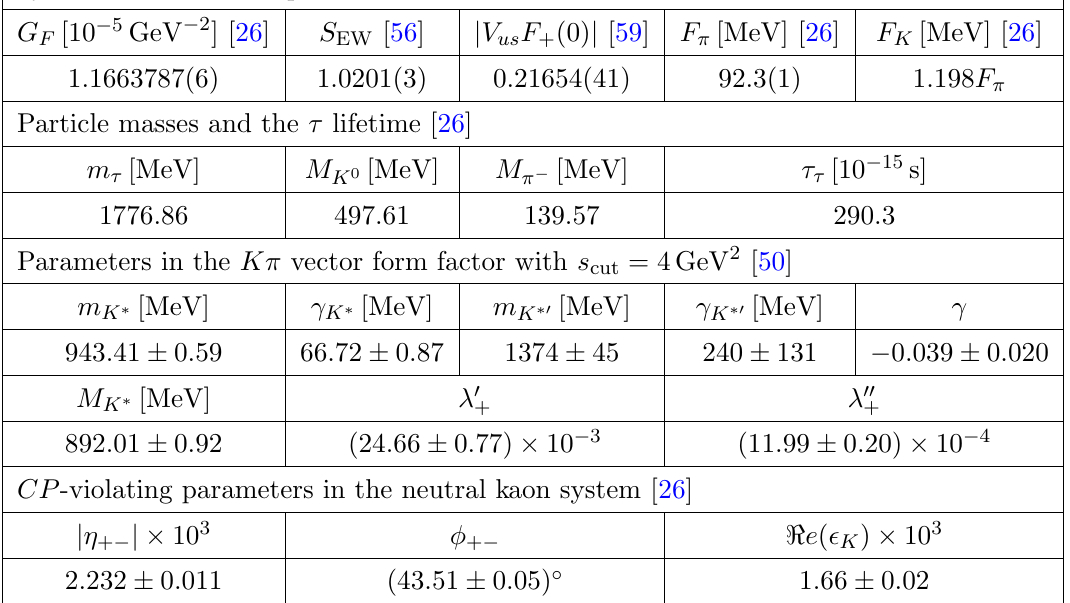
Table 1 . Summary of the input parameters used throughout this